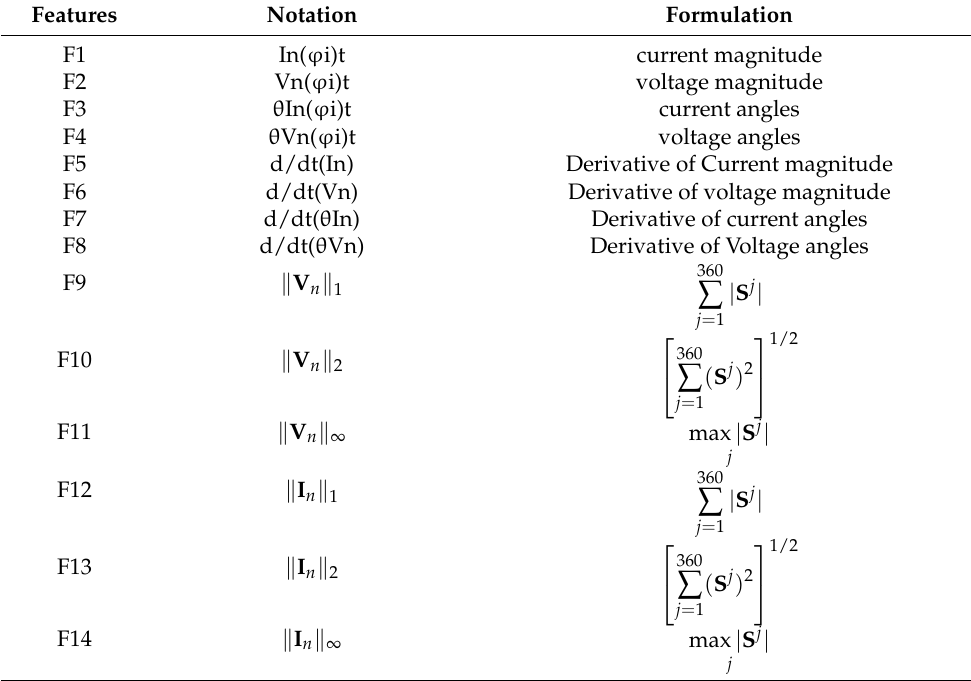
Table 1. Feature Vectors for Fault